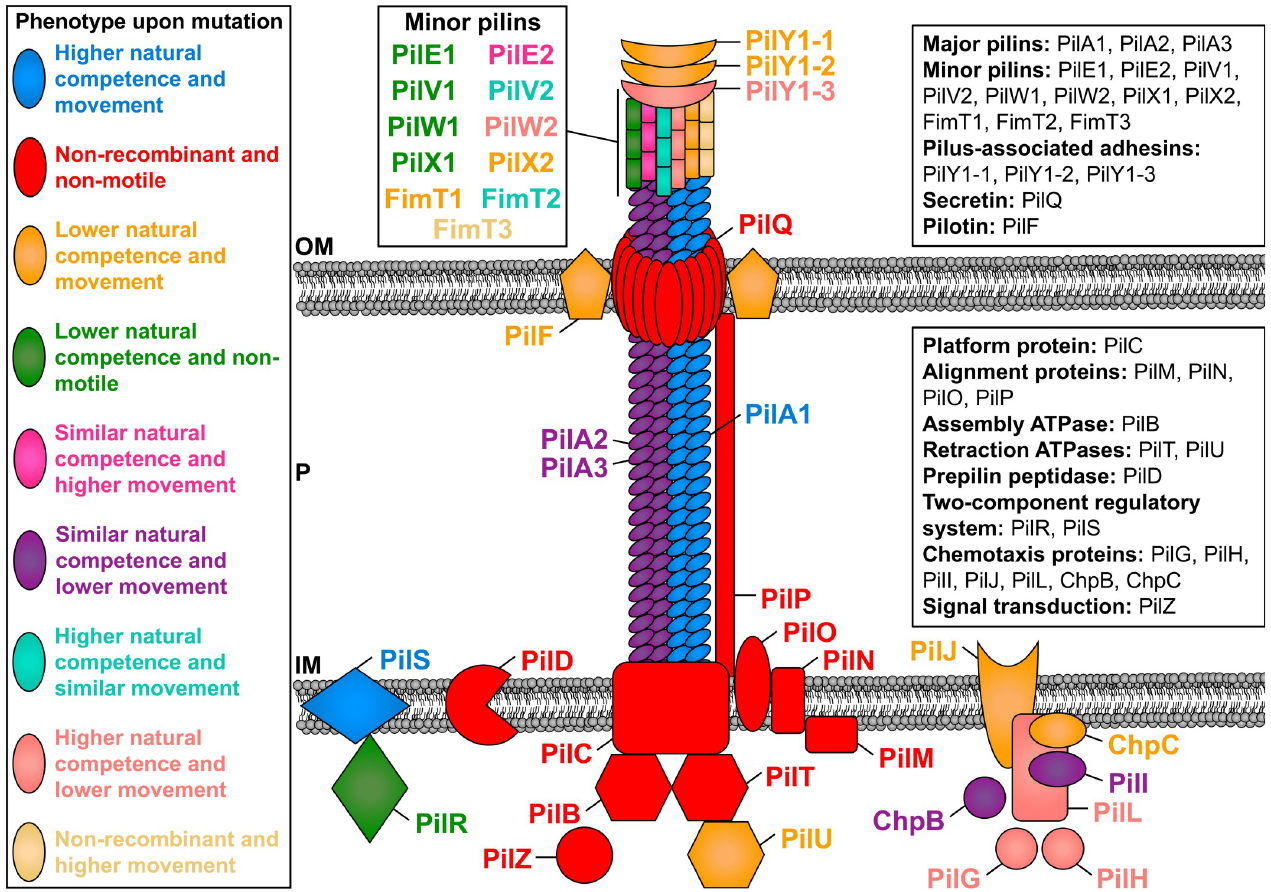
Fig 5. Schematic representation of the functional role of TFP molecular components in natural competence and twitching motility of X . fastidiosa . The figure shows the structure of a type IV pilus (PilA1, PilA2 and PilA3), the alignment subcomplex (PilM, PilN, PilO and PilP), the inner membrane motor subcomplex (PilB, PilC, PilD, PilT and PilU), the pore subcomplex (PilF and PilQ), minor pilins (PilE1, PilE2, PilV1, PilV2, PilW1, PilW2, PilX1, PilX2, FimT1, FimT2 and FimT3), TFP tip adhesins (PilY1-1, PilY1-2 and PilY1-3), as well as regulatory proteins (PilG, PilH, PilI, PilJ, PilL, PilR, PilS, PilZ, ChpB and ChpC). Proteins in the figure are color-coded according to their phenotype upon knockout mutation and thus functional role. More information about the role of each protein is described in S1 Table, throughout the manuscript and in SI Discussion in S1 Text. OM–outer membrane; P–periplasm; IM–inner membrane.